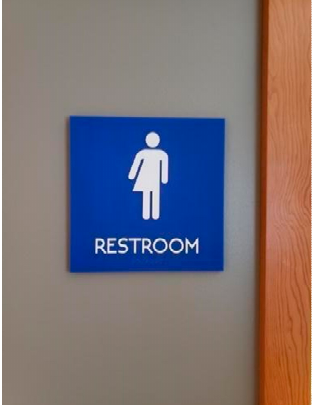
Figure 5. “We Don’t Have a ‘Men’s’ Bathroom” (Rowan).